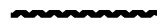
Comparison of the RPL23A amino acid sequences among the different species.
: N-glycosylation site;
: Protein kinase C phosphorylation site; □: Tyrosine kinase phosphorylation site;
: Ribosomal protein L23 signature;
: polymorphism site. (Pa: A. melanoleuca; Ho: Homo sapiens; Mu: Mus musculus; Ra: Rattus norvegicus; Ma: Macaca mulatta).